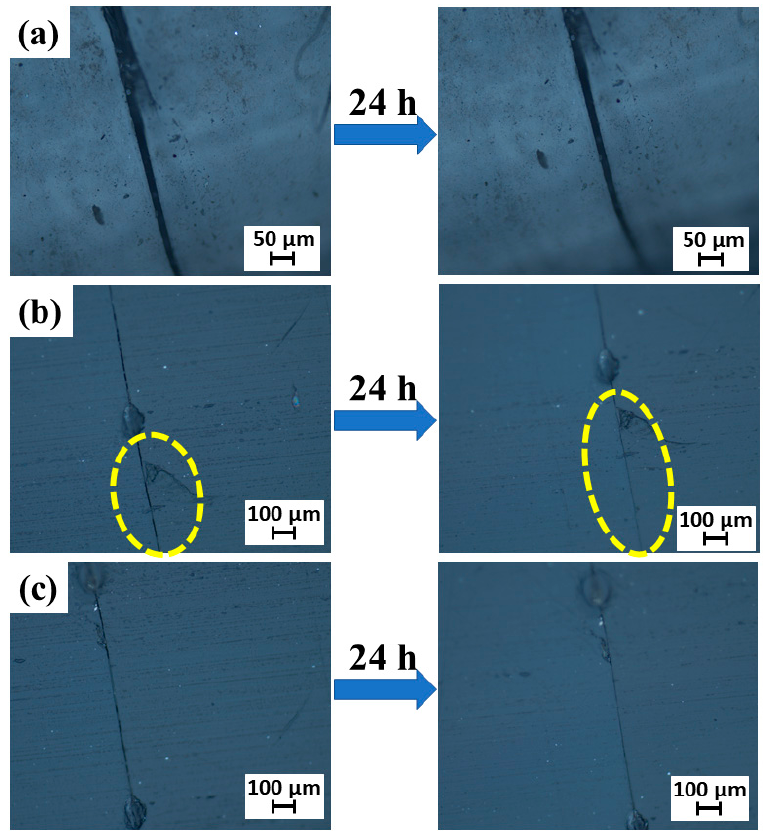
Figure 7. Images of a cracked plane after healing with epoxy coatings with ( a ) 0 wt% MC2, ( b ) 10 wt% MC2 and ( c ) 20 wt% MC2.